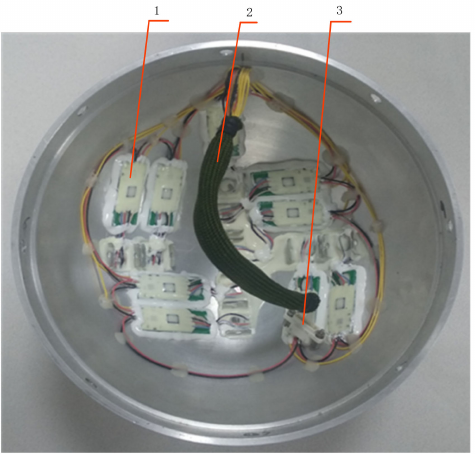
Figure 12. Physical diagram of pressure sensors. 1-Pressure sensors, 2-Data cables, 3-Plug-in.